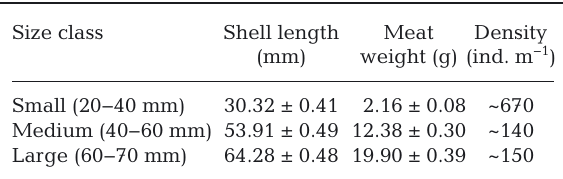
Table 1. Perna canaliculus . Average shell length (±SE), meat weight (±SE), and stocking density of mussels within